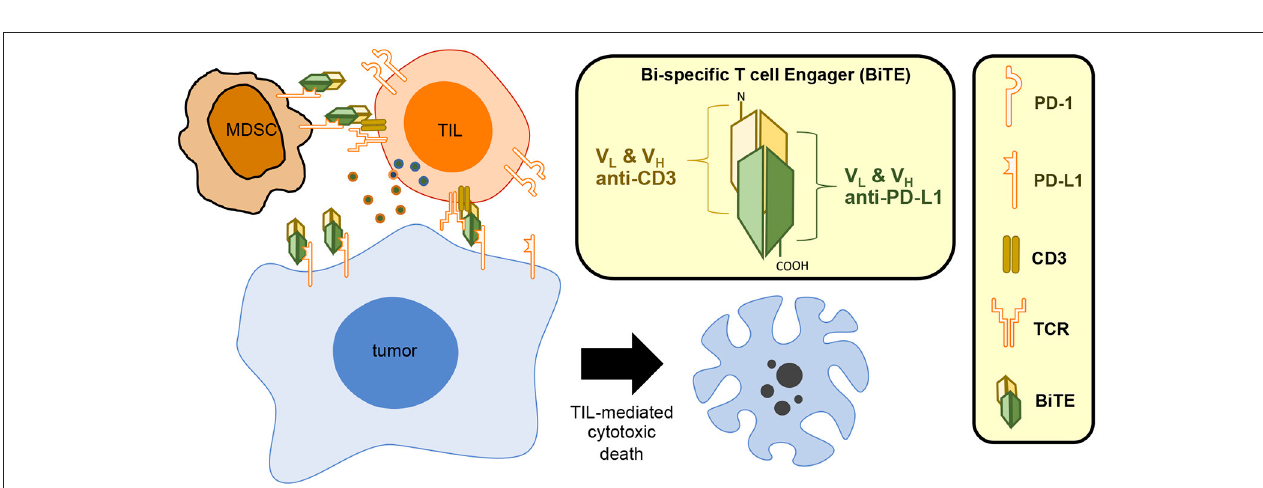
FIGURE 2 | CD3xPDL1 BiTE blocks PD-L1 and induces T cell-mediated cytotoxic death . The CD3xPDL1 BiTE consists of the V H and V L regions of anti-CD3 and anti-PDL1 linked together to form a 55 kDa single chain structure. The CD3xPDL1 BiTE binds to PD-L1 on PD-L1 + tumor cells blocking interaction with PD-1 on T cells, thereby preventing PD-1 mediated T cell exhaustion. The BiTE simultaneously binds to CD3 on CD4 + T cells, CD8 + T cells, and NKT cells, activates the cells, and forms a cytotoxic synapse. The activated effector cells then kill the PD-L1 + tumor cells.